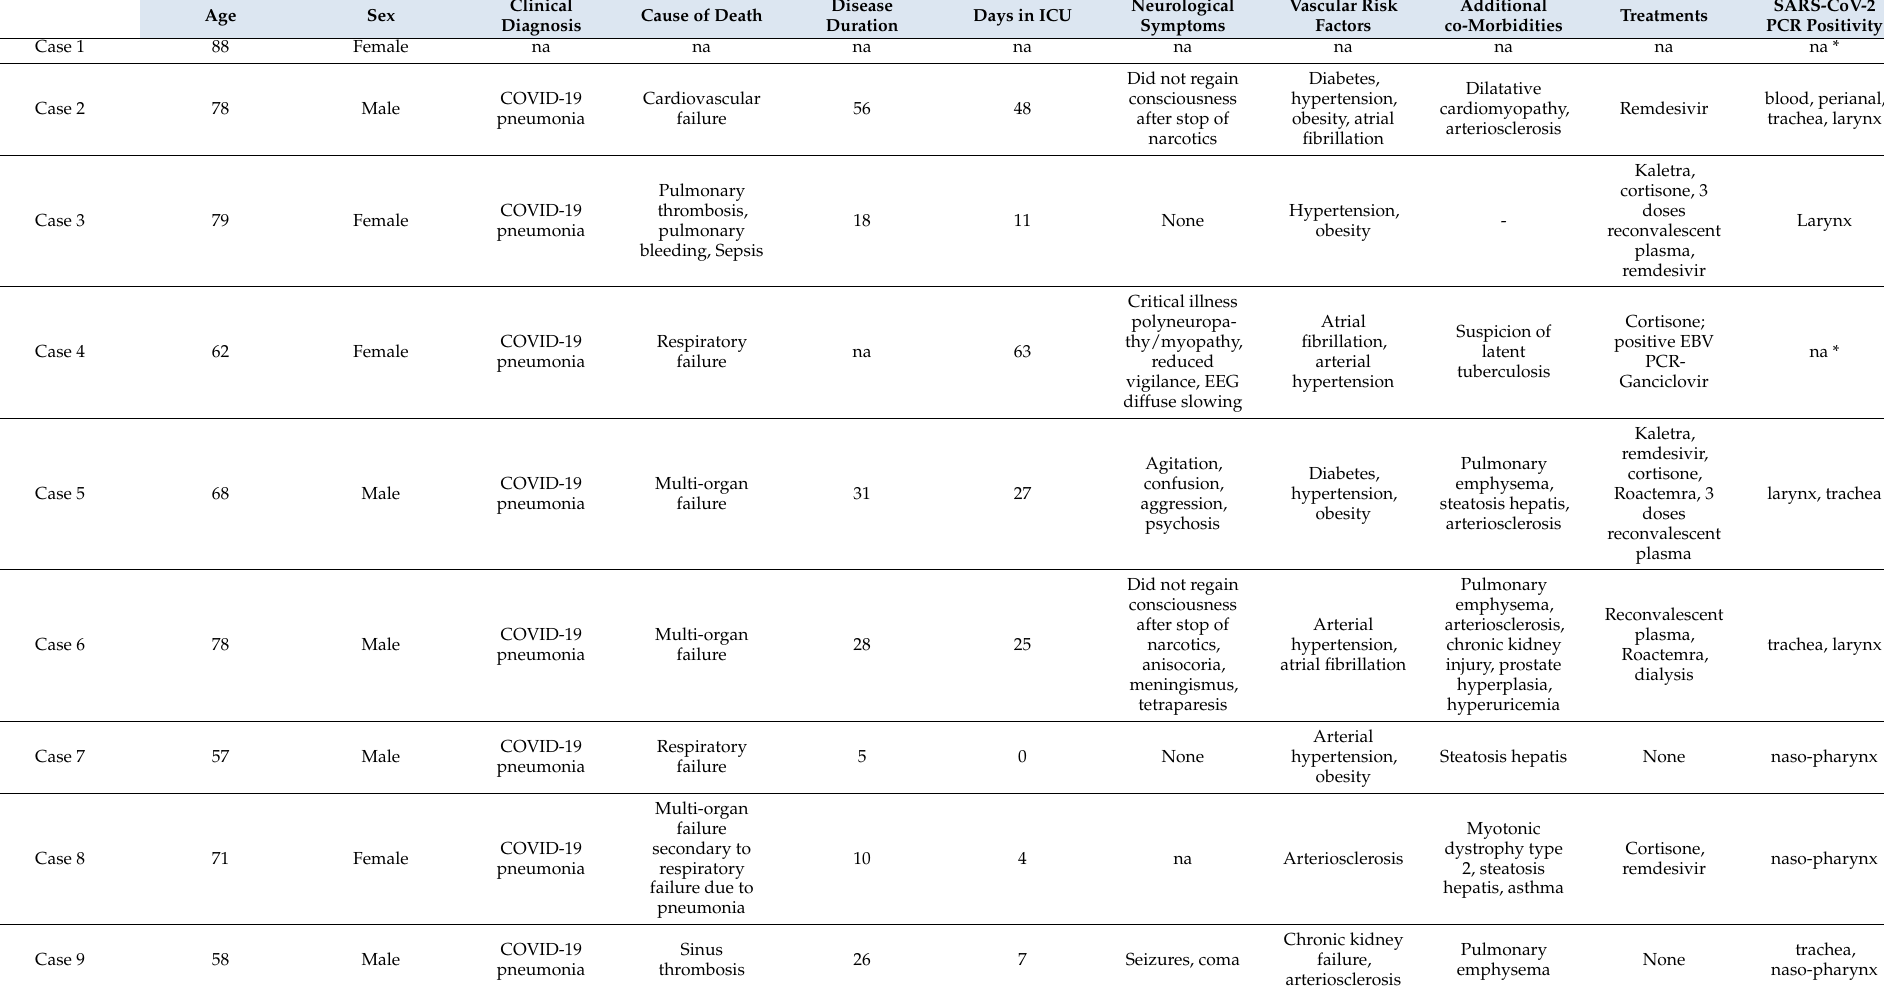
Table 1. Basic clinical